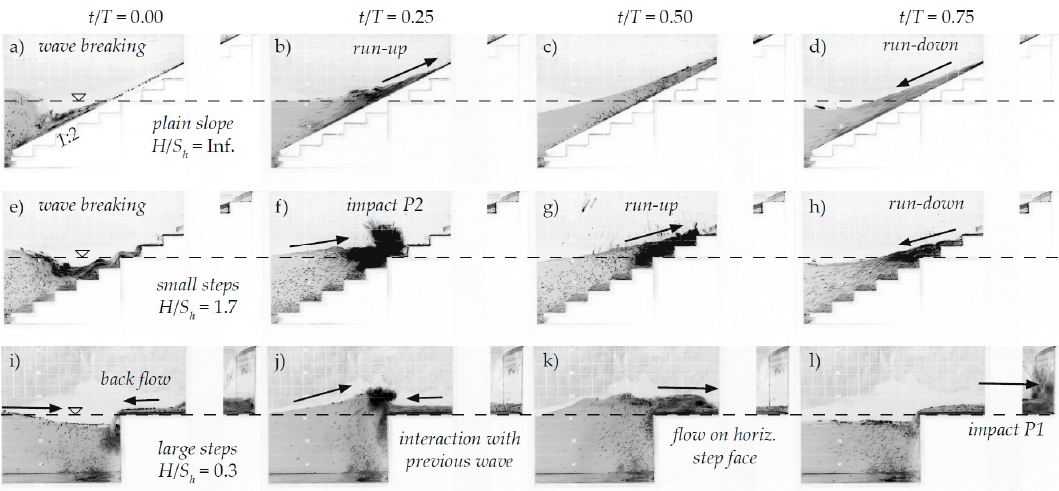
Figure 3. Demonstration of flow processes for relative time-steps in the run-up process on revetments with smooth surface ( a – d ), small step heights ( e – h ), and large step heights ( i – l ). On a smooth plain slope, a breaking wave induces air in the water body. The wave run-up (b) contains water and air. At the maximum point of wave run-up excursion (c) the entire fraction of air is leaked from the water body, and in consequence, the wave run-down (d) contains only water. During the wave run-down the preceding wave then interacts with the next incoming wave and the described run-up and aeration process is repeated. For revetments with small steps ( H / S h = 1.7), the general flow processes of wave breaking, wave run-up and wave run down sequence is almost in analogy with the processes on a smooth slope. The main differences are: (1) The impact of the breaking wave causes a splash-up at the vertical step front (f) during the wave run-up process, (2) the aeration during the wave run-up is more intense during the run-up process caused by larger friction induced by the steps (g). Yet, in contrast, the wave run-down induces air into the water body and is retarded compared